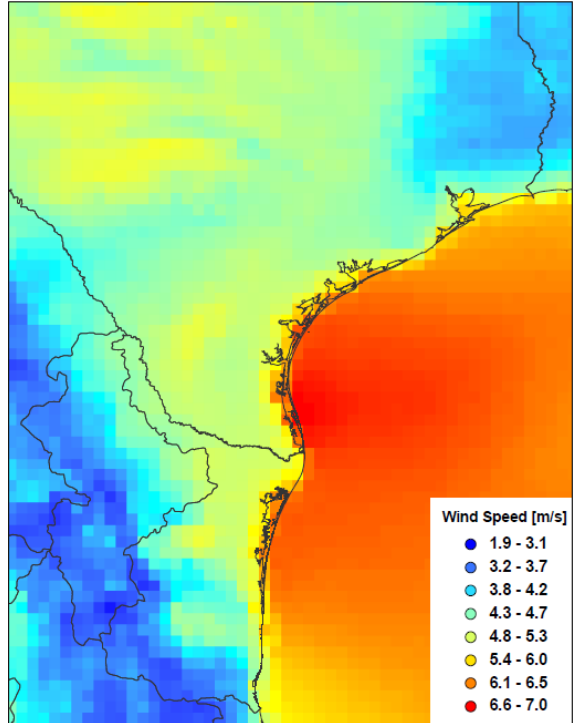
Figure 24. Surface wind speed map (10 m) for Southern Texas and Northeastern Mexico created from the North American Mesoscale (NAM) Model output for one